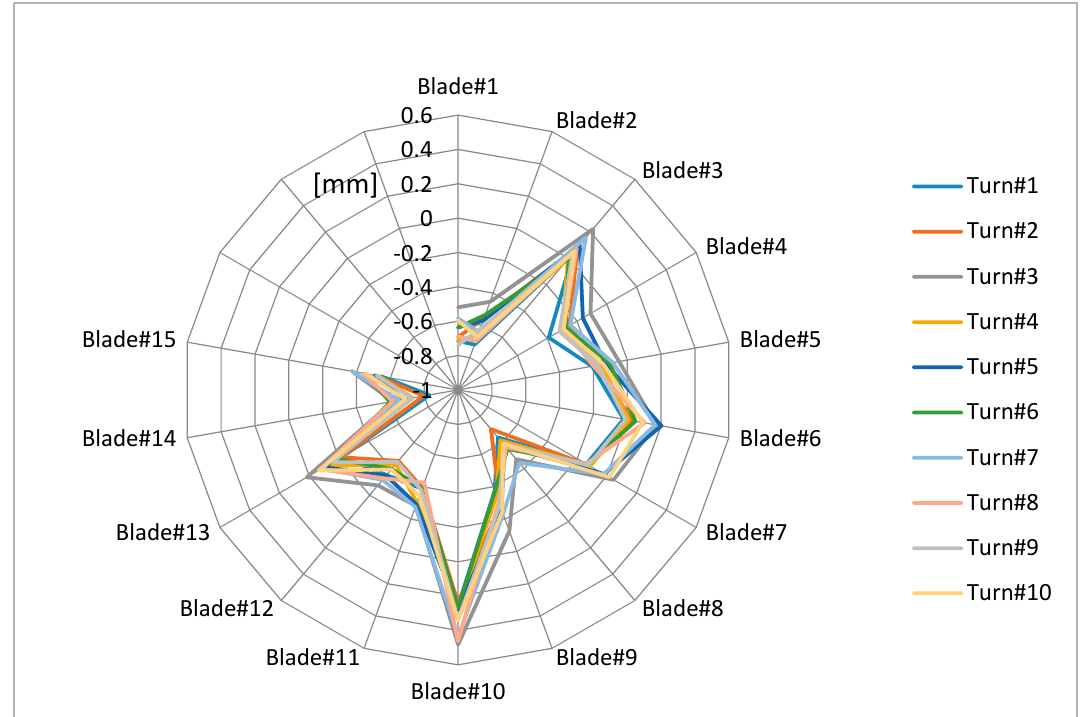
Figure 16. Deflections for 15 blades and 10 consecutive revolutions.